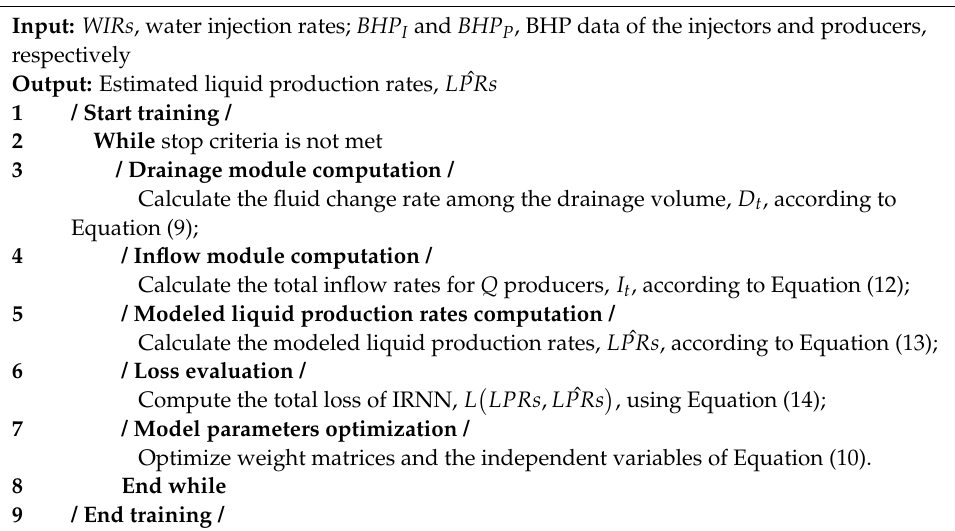
Algorithm 1: The training pseudocode for IRNN.